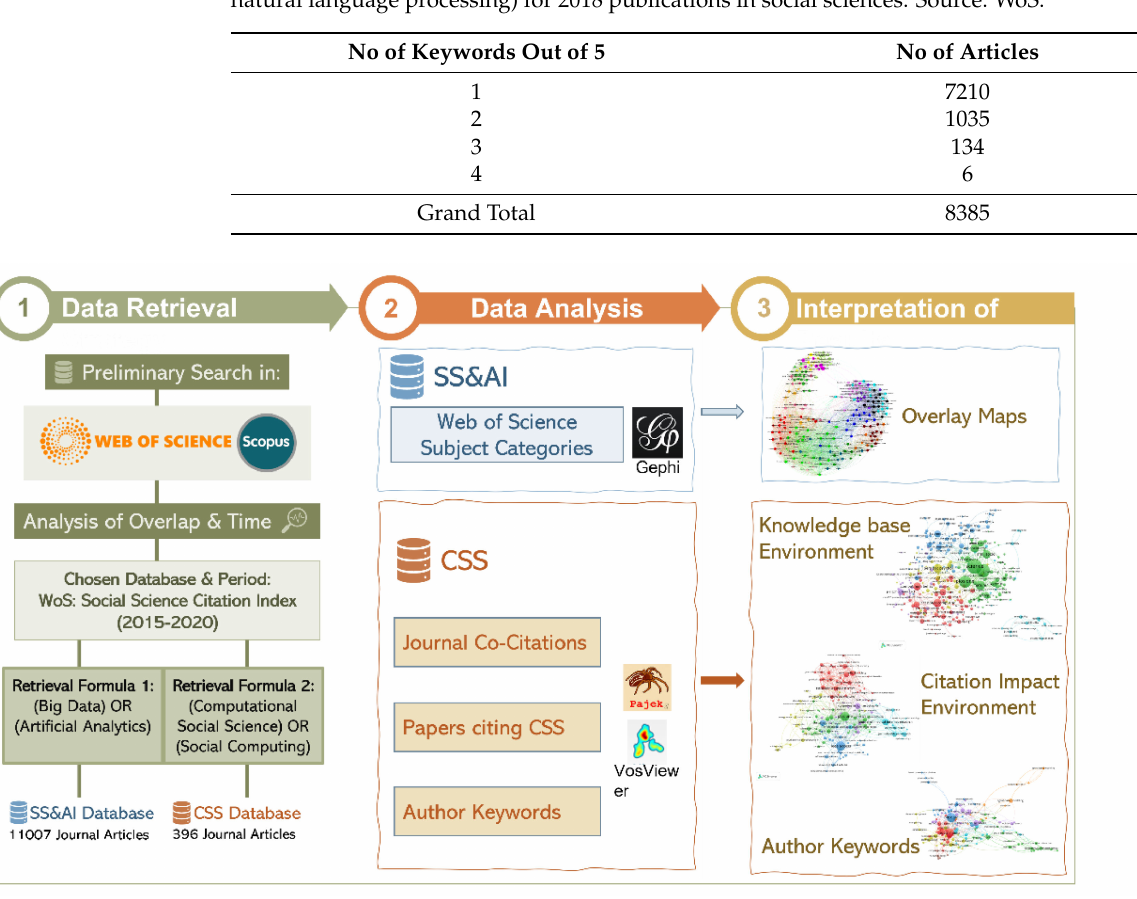
Figure 2. Flow chart of the bibliometric